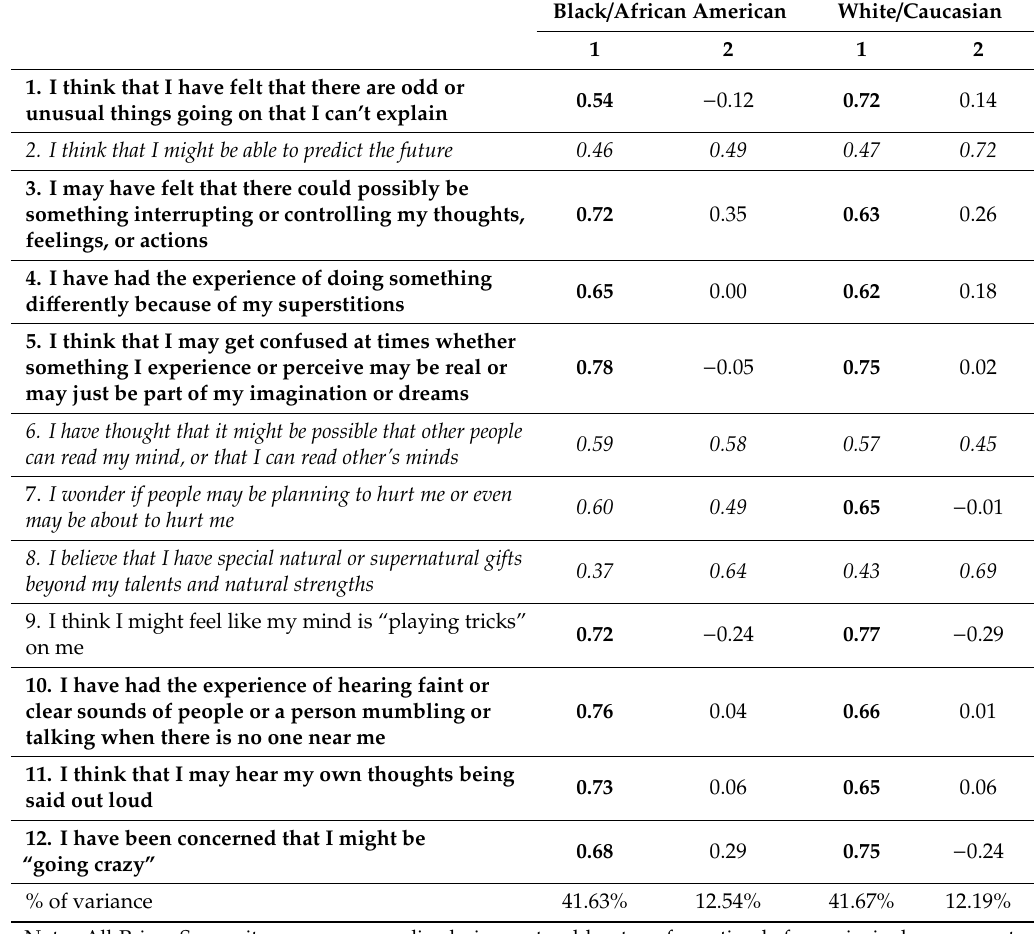
Table 3. Component Loadings for Principal Components Analysis of Prime Screen